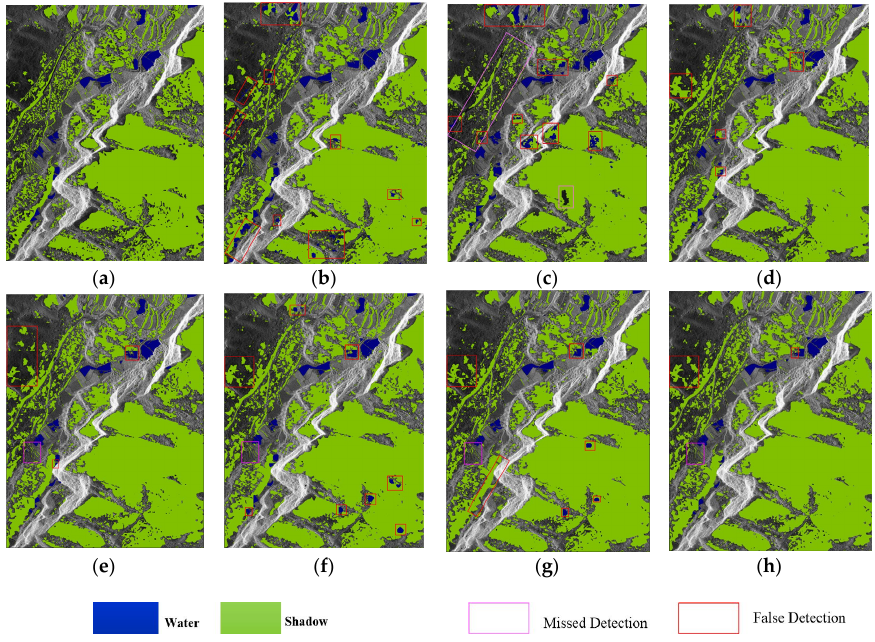
Figure 16. The fusion map of classification results by different methods. ( a ) Ground truth. ( b ) RefineNet. ( c ) DeepLabV3. ( d ) MLSAN. ( e ) GLGCM-MLSAN. ( f ) Gabor-MLSAN. ( g ) MSOGDF-MLSAN. ( h ) MSF-MLSAN.